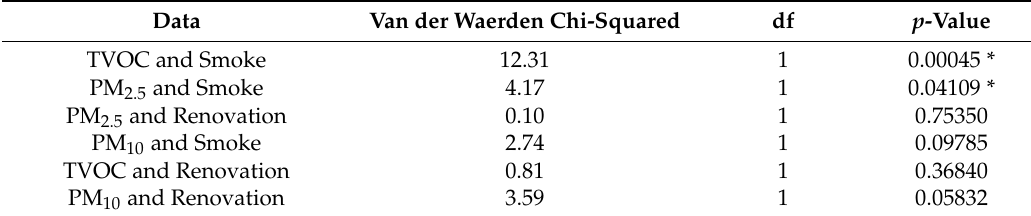
Table 5. Results of the Van der Waerden test for univariate cases.